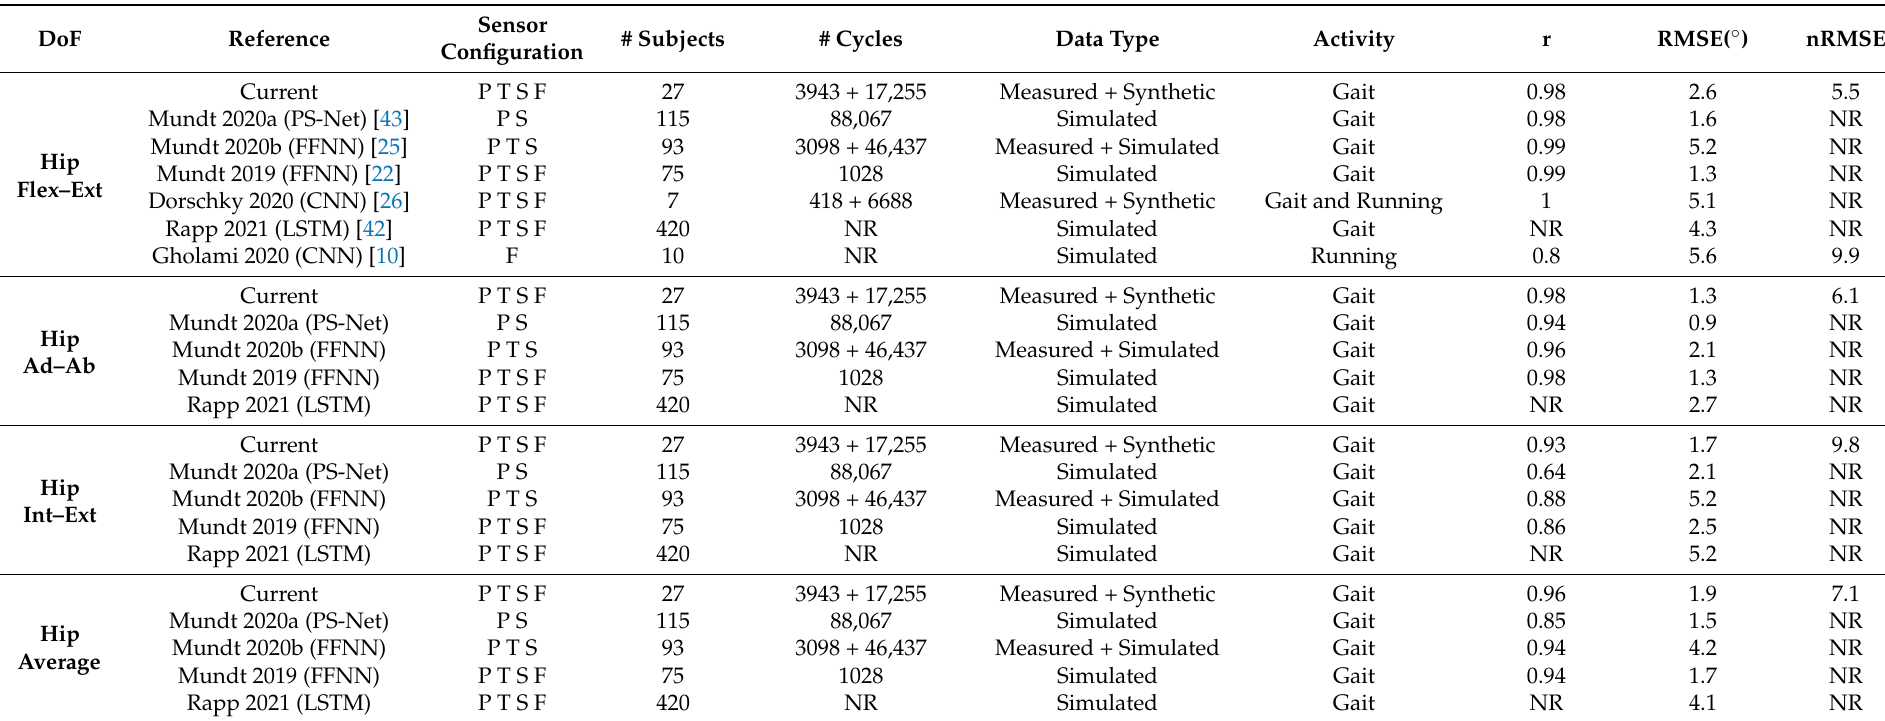
Table 4. Reported prediction accuracy compared with previous studies for hip kinematics. Sensor configurations included pelvis (P), thigh (T), shank (S), and foot (F). Synthetic data were data generated by augmented kinematics data, while simulated data were generated by existing motion capture